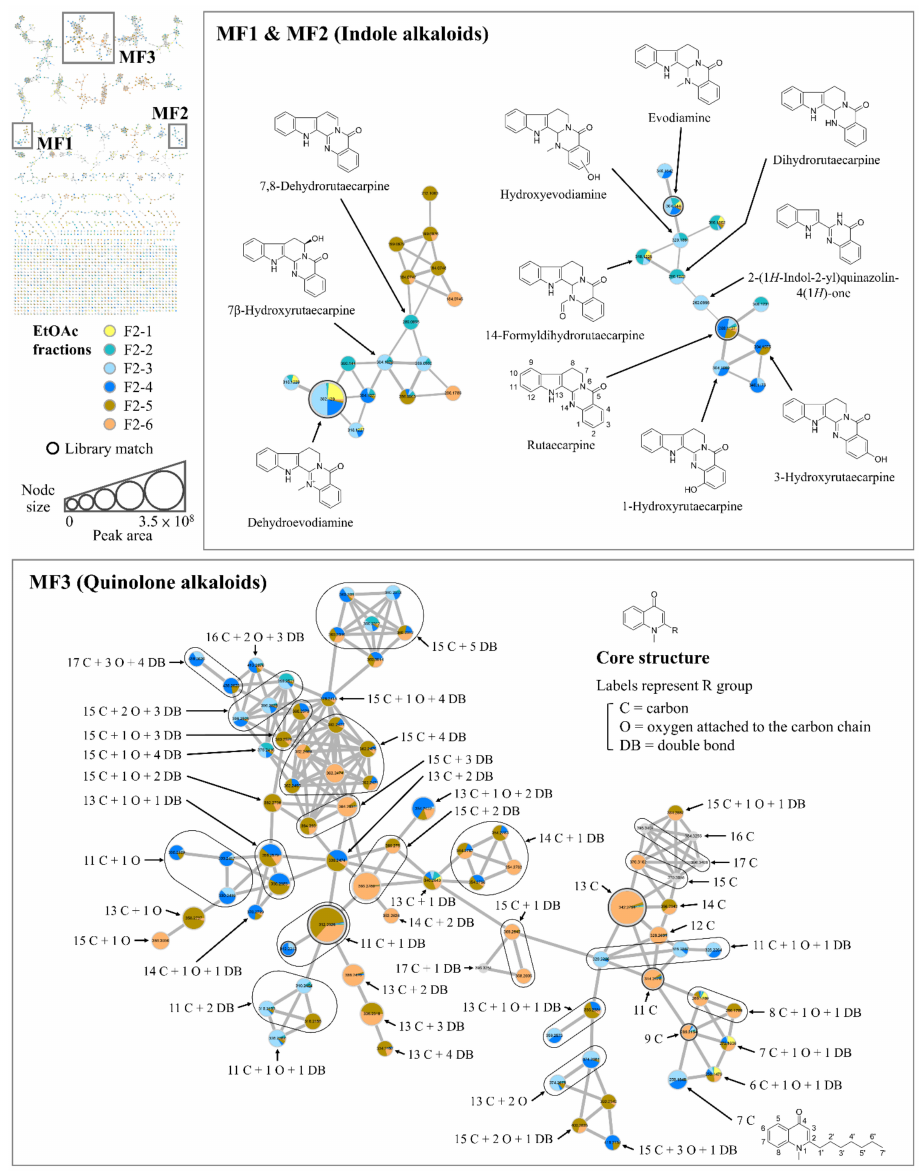
Figure 1. Molecular network of the EtOAc fractions of T. ruticarpum fruit and the targeted molecular families (MF) containing indole alkaloids and quinolone alkaloids. Values in the nodes are precursor m / z . Nodes colored in gray are derived from other EtOAc fractions rather than F2-1–F2-6. The node size is proportional to the sum of the chromatographic peak area. The edge width is proportional to the MS/MS spectral similarity between two connected molecules. The threshold of library match is cosine score ≥